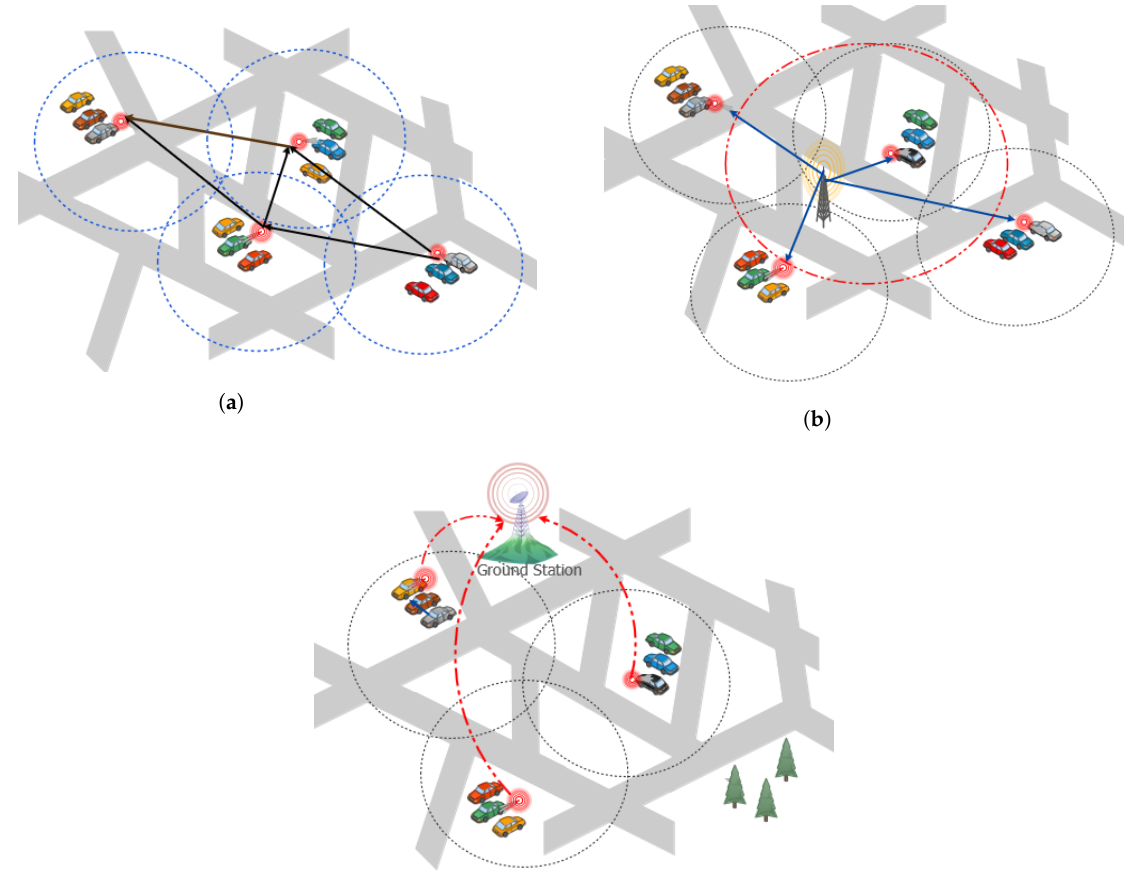
Figure 5. Modes of operation for parked cars acting as RSUs. ( a ) Parked cars form a mesh network with point-to-point links to other parked cars. ( b ) Parked cars extend the range of a fixed 802.11p RSU, acting as relays to it. ( c ) Parked cars with access to an uplink establish them selves as standalone